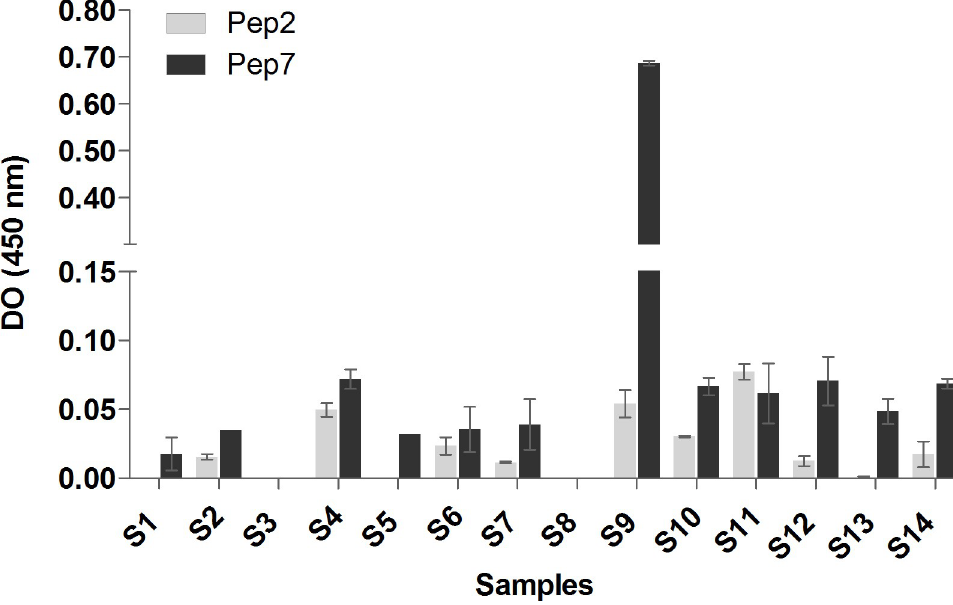
Fig 5. Validation of Pep2 and Pep7 of LruC protein by recognition of antibodies from sera of leptospirosis patients, by ELISA. The ELISA measured the recognition of the selected peptides by the sera of leptospirosis patients (S1 to S14). The graphic represents the average and standard deviation of optic density (DO) of the duplicates using 10 μ g of peptides incubated with the human sera. The values were subtracted by the background recognition of control serum.